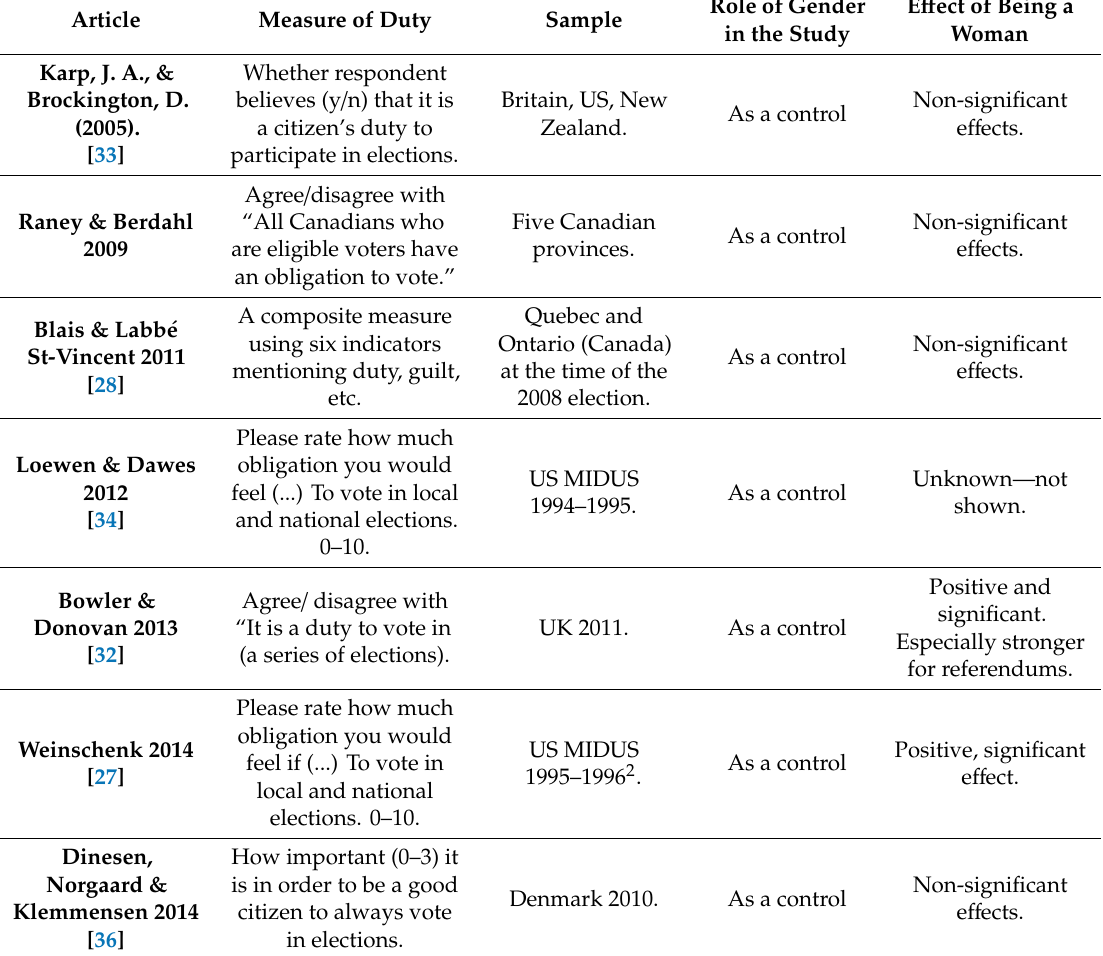
Table 1. Review of the literature on the e ff ects of gender on the civic duty to